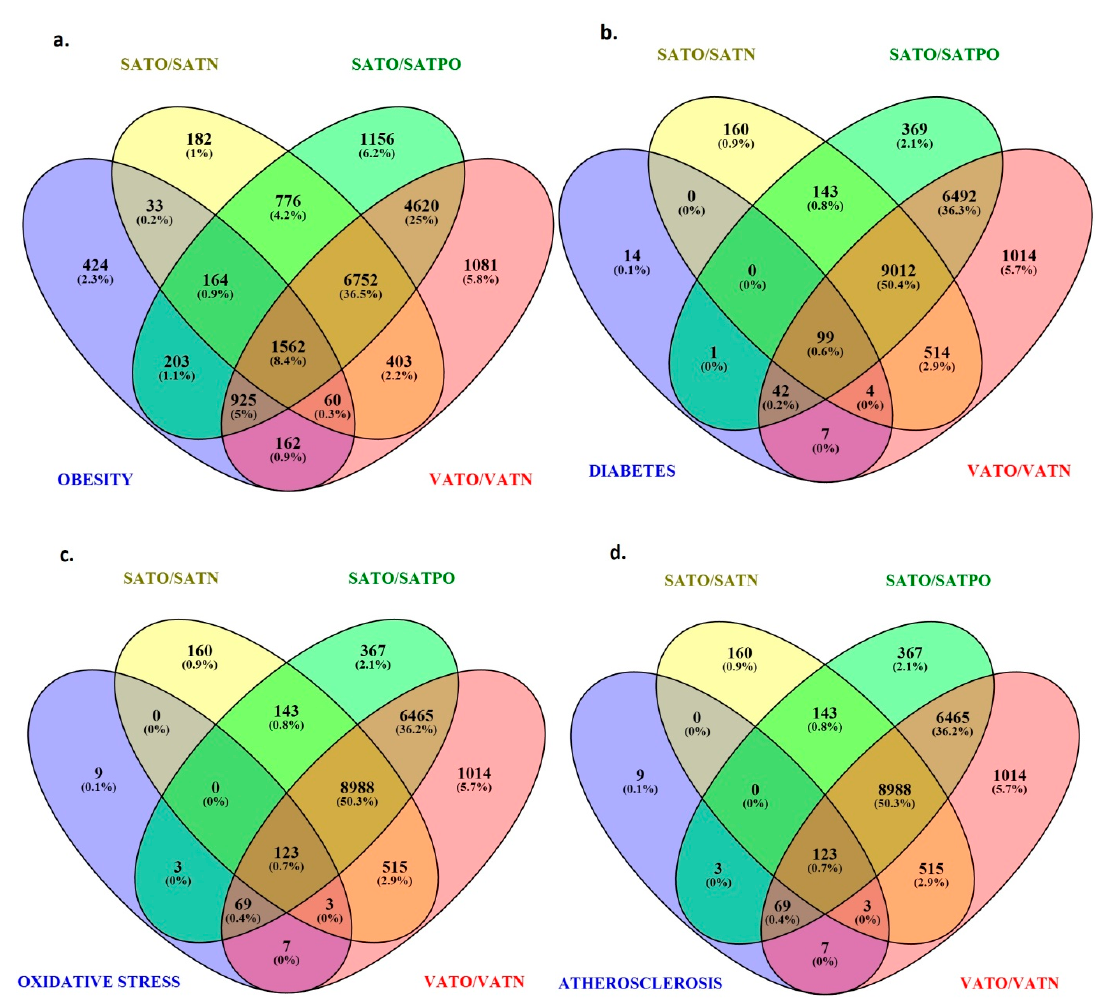
Figure 1. Venn’s diagrams showing involvement of genes regulated by miRNAs differentially expressed in subcutaneous (SAT) and visceral (VAT) adipose tissues from obese (O), normal weight (N), obese after weight-loss (PO) individuals in pathogenesis of obesity ( a ), diabetes ( b ), oxidative stress ( c ) and atherosclerosis ( d ).